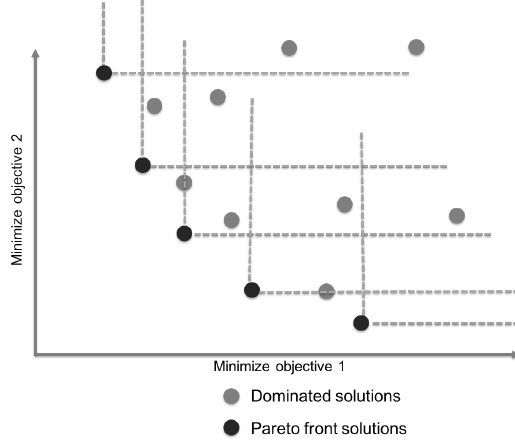
Figure 1. The Pareto front of a set of solutions in a two-objective